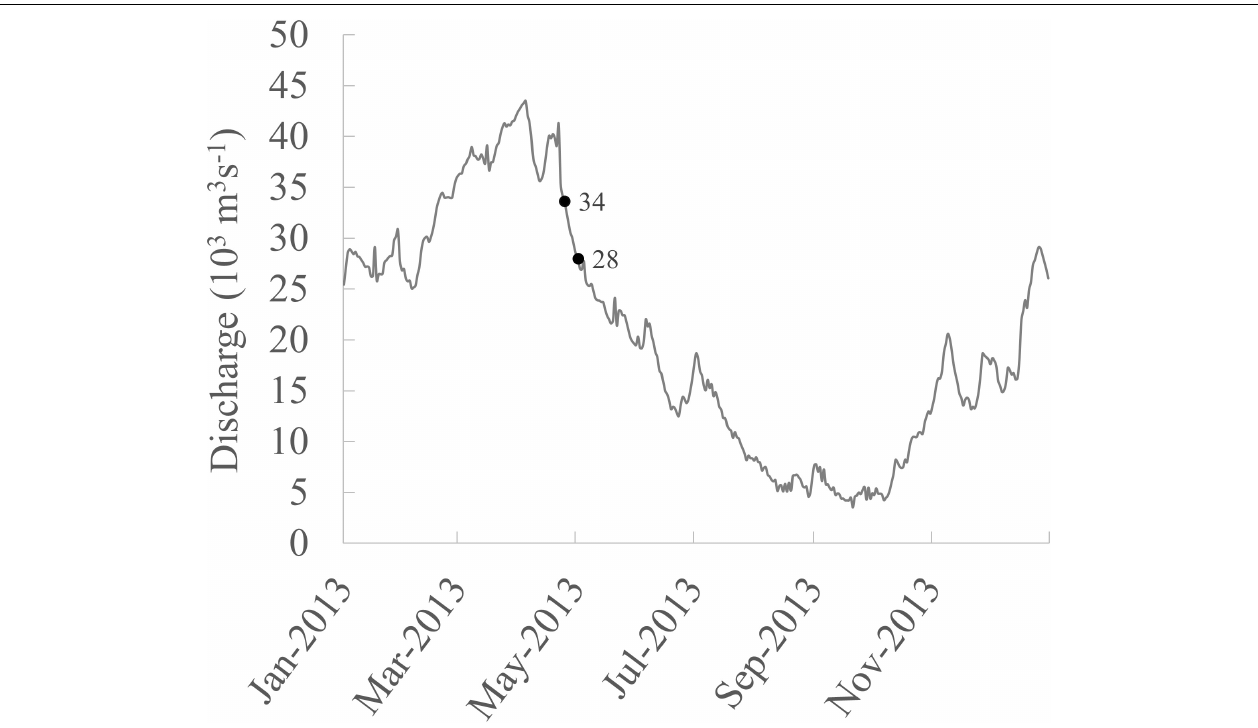
FIGURE 2 | Daily discharge in 2013 measured at station 15400000 (Brazilian National Water Agency–ANA, available at www.snirh.gov.br/hidroweb/). The station is located downstream of the Santo Antônio dam in front of Porto Velho. The numbers in the figure indicate the discharge measured at the first and last days of